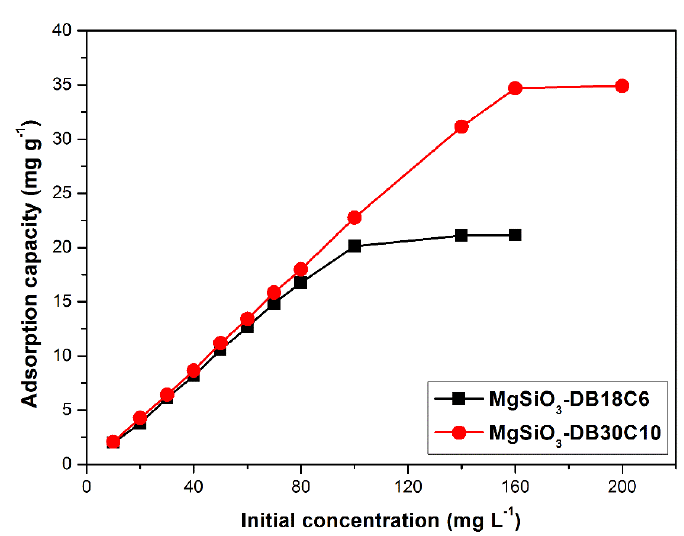
Figure 8. Initial concentration effect on the adsorption capacity of the functionalized adsorbents.